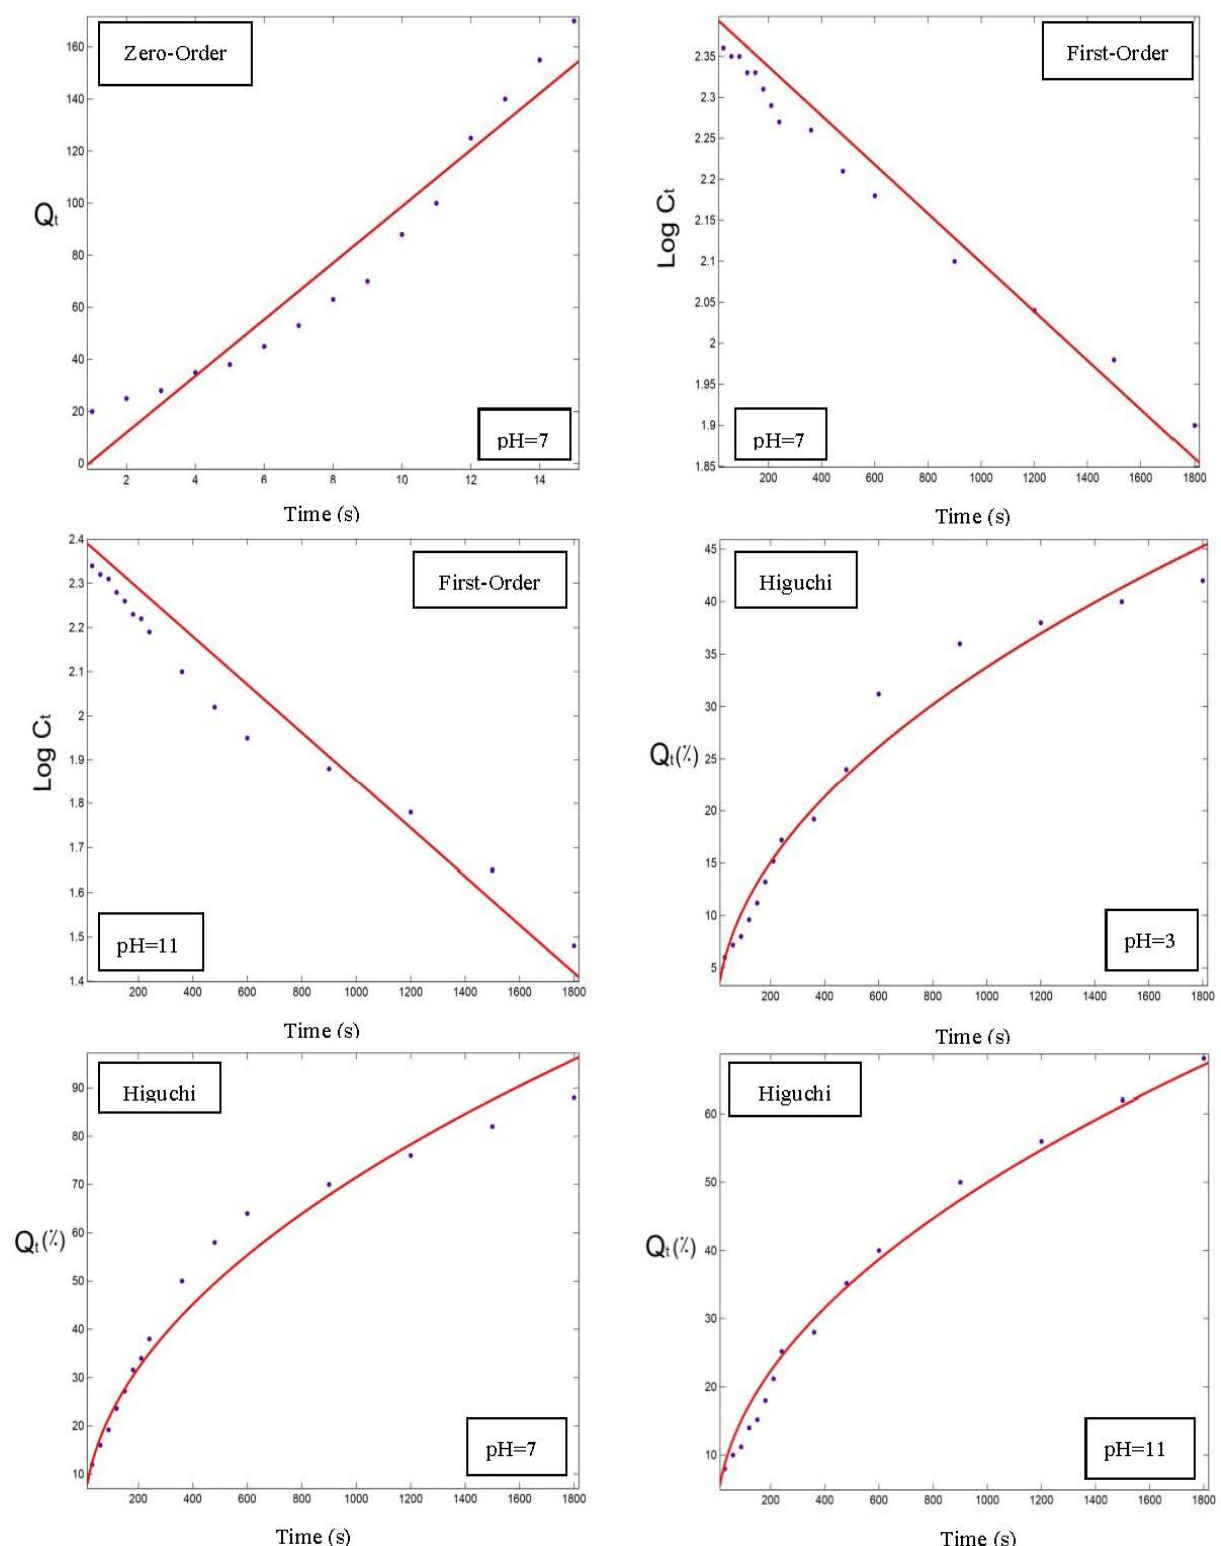
Figure 7. Release profiles (dots) and regression modeling (red lines) of orange peel oil dissolution from nano-delivery system of pectin–whey protein powder particles (NC3) at 60 °C and different pH values.